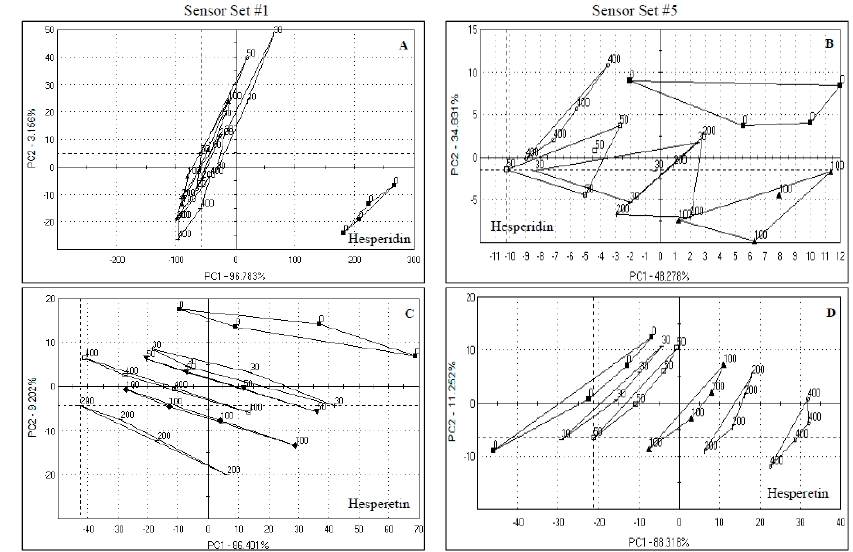
Figure 4. Principal component analysis of orange juice spiked with hesperidin and hesperetin. Numbers in the graphs indicate the concentrations used (µg/mL juice). Samples presented were analyzed by sensor set #1 and 5. ( A ) Hesperidin by Set #1; ( B ) Hesperidin by Set #5; ( C ) Hesperetin by Set #1; ( D ) Hesperetin by Set #5.